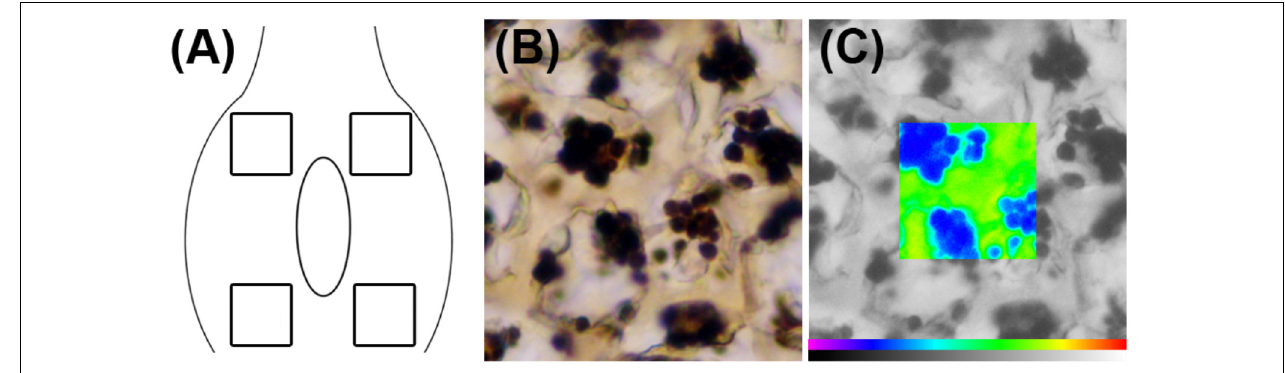
FIGURE 1 | Starch quantification in sweet cherry ovary primordium. (A) Diagram of the ovary primordium, showing the regions in which starch content was measured. (B) Image of an I 2 KI-stained sample for starch. (C) Pseudocolor image corresponding to starch (in blue) on the black and white original image.